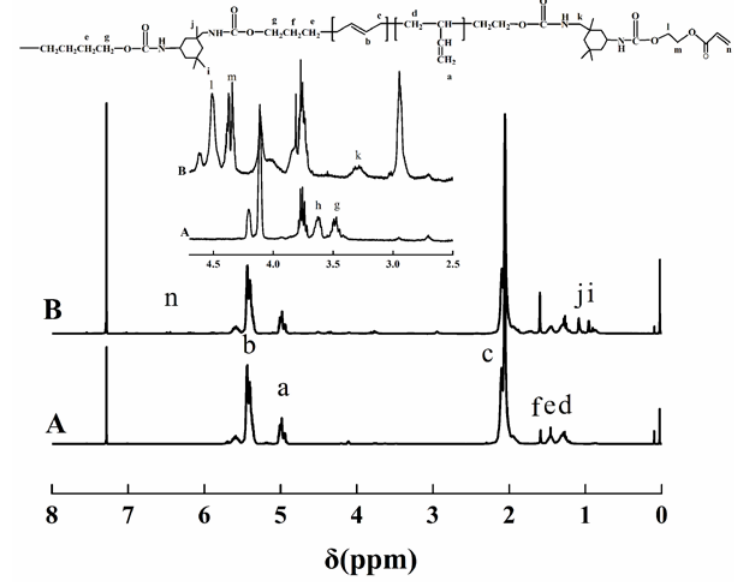
Figure 2. 1 H NMR spectra of HTPB and HTPU in CDCl 3 .